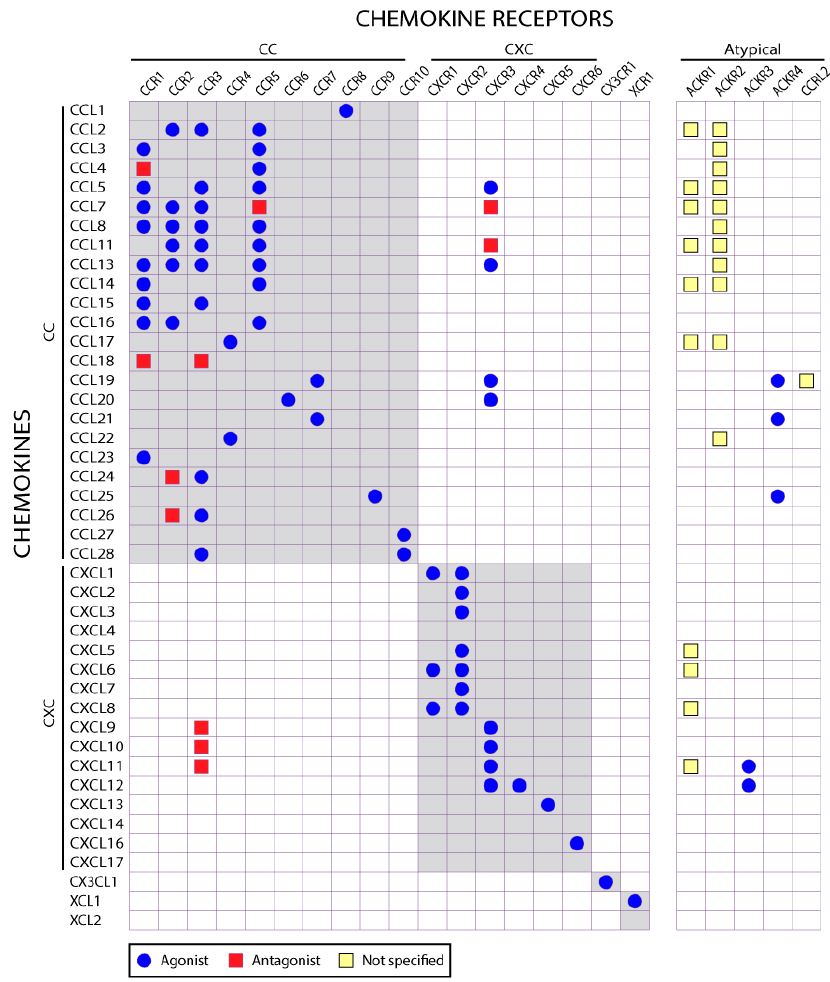
Figure 2. The human chemokine-receptor network. Human chemokines and receptors are listed with symbols indicating whether they are specified as agonists or antagonists (or not specified) in the IUPHAR database. Note that, although CXCL1 is listed as a CXCR1 agonist in IUPHAR, the database reference suggests that it is actually an antagonist [11].